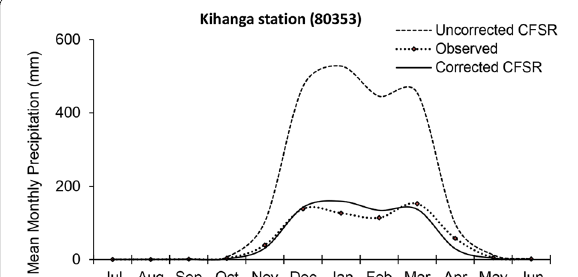
Fig. 7 Climate forecast system reanalysis rainfall data before and after bias